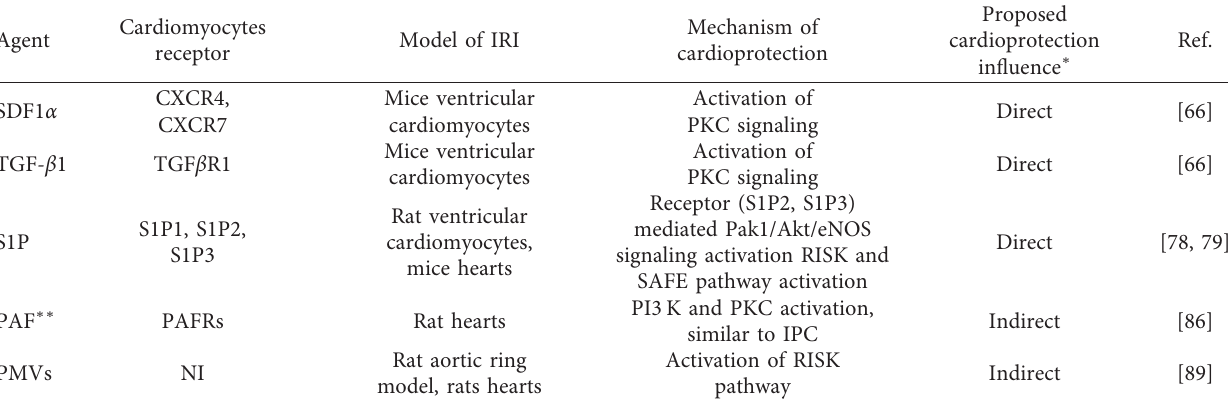
Table 1: Description of cardioprotection mediated by platelet